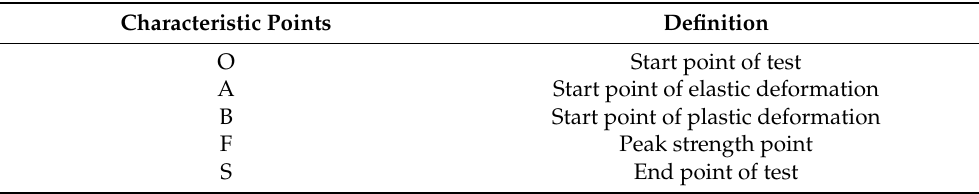
Table 2. The definitions of the characteristic points on the stress–strain curve.